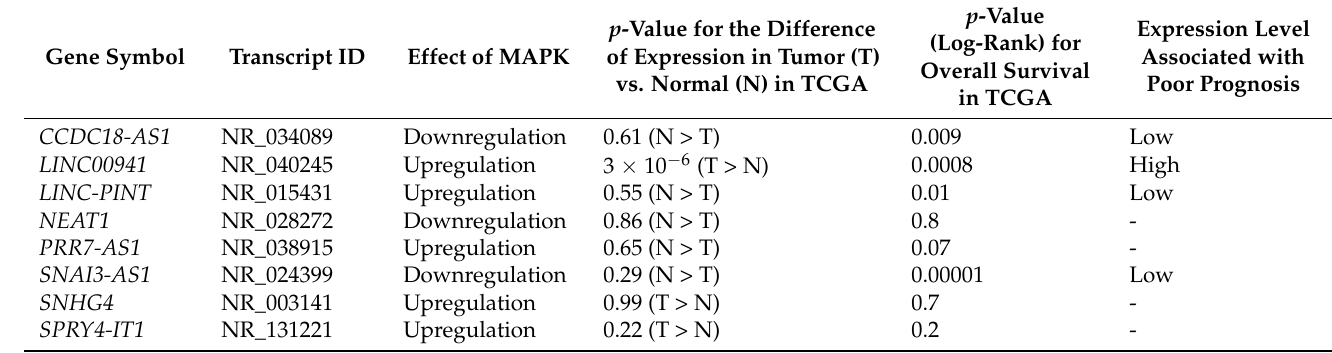
Table 1. MAPK-regulated lncRNAs.